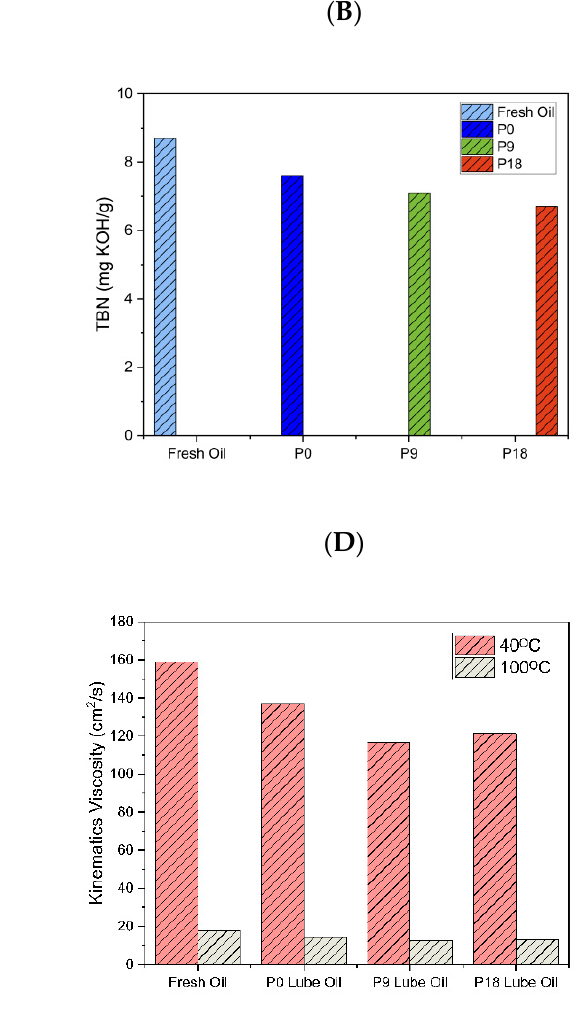
Figure 2. ( A – D ) Comparison of kinematic viscosity, TBN, flash point, and water content for the lubricant oils.